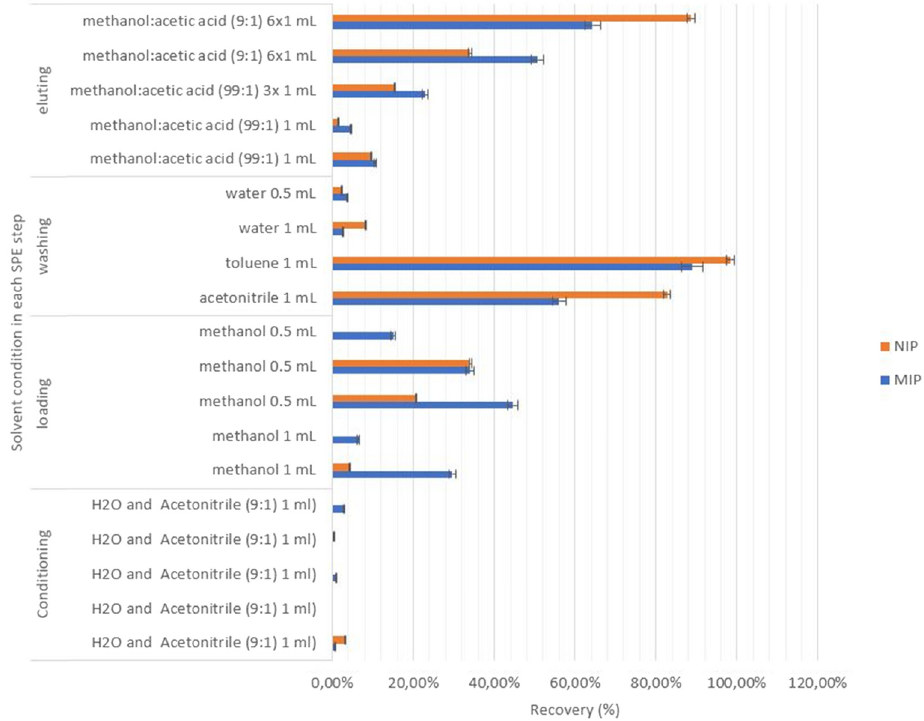
Figure 5: SPE optimisation result according to di ff erent conditioning solvents, washing, and eluting conditions based on solvent type and volume of the solvents used.